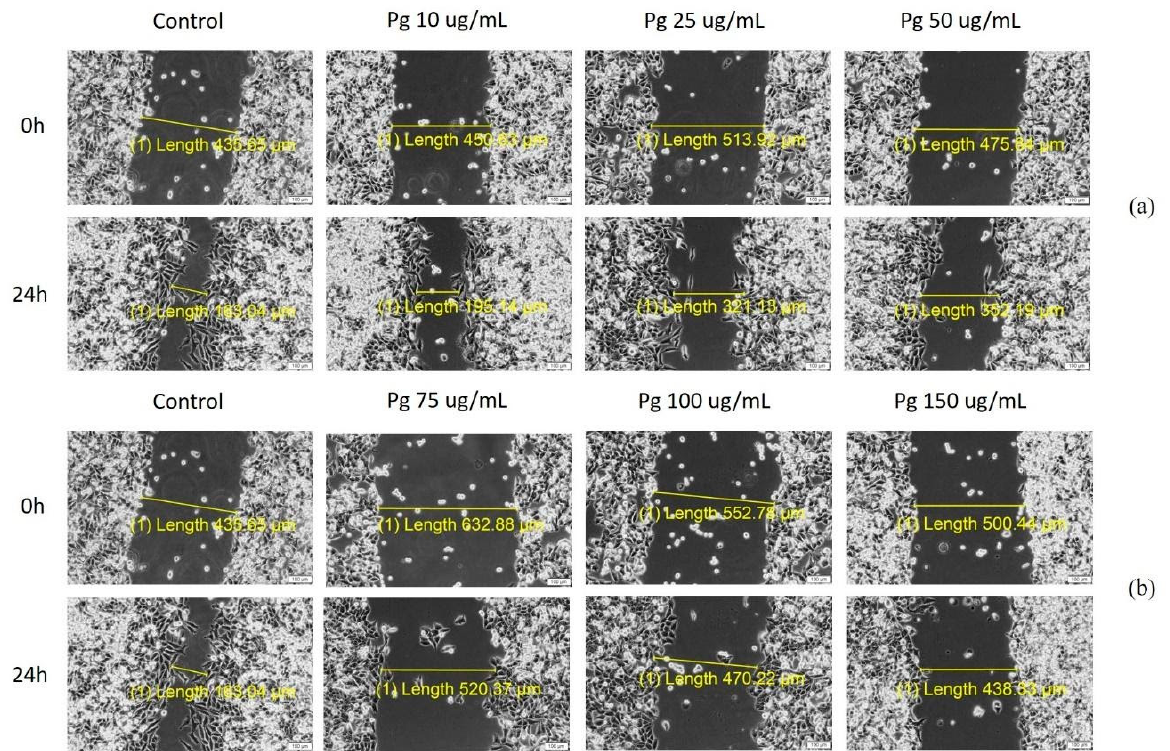
Figure 3. Pg extract ( a ) (10, 25 and 50) and ( b ) (75, 100, and 150 µg/mL) activity on A549 human lung adenocarcinoma cells’ migration and proliferation potential. Progression of cell migration was monitored by imaging the scratch line initially and at 24 h post-stimulation. Images were taken by light microscopy at 10× magnification.